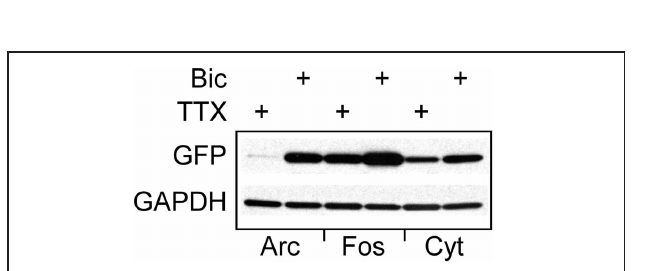
FIGURE 4 | Comparing the Cycs enhancer to other activity-regulated enhancers. Arc enhancer (48h TTX), Arc enhancer (48h bicuculline), Fos enhancer (48h TTX); Fos enhancer (48h bicuculline), Cycs enhancer (48h TTX), Cycs enhancer (48h bicuculline). Glyceraldehyde-3-phosphate dehydrogenase (GAPDH) was used as a loading control.